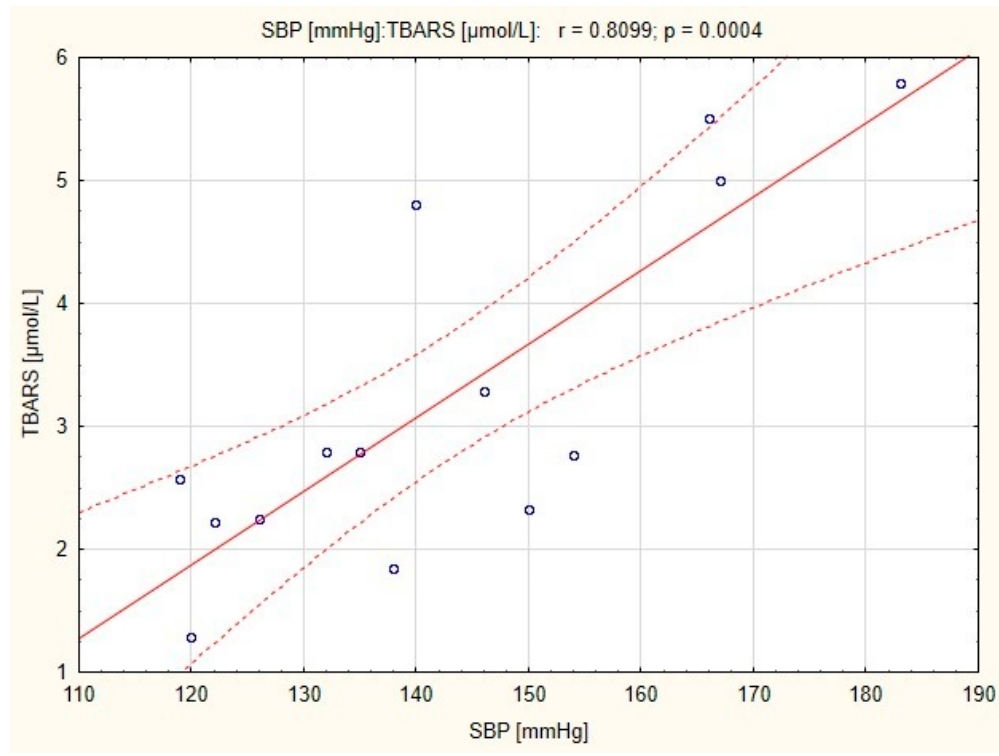
Figure 3. Correlation between resting systolic blood pressure (SBP) and thiobarbituric acid reactive substances (TBARS) concentration in women with obesity before the combined